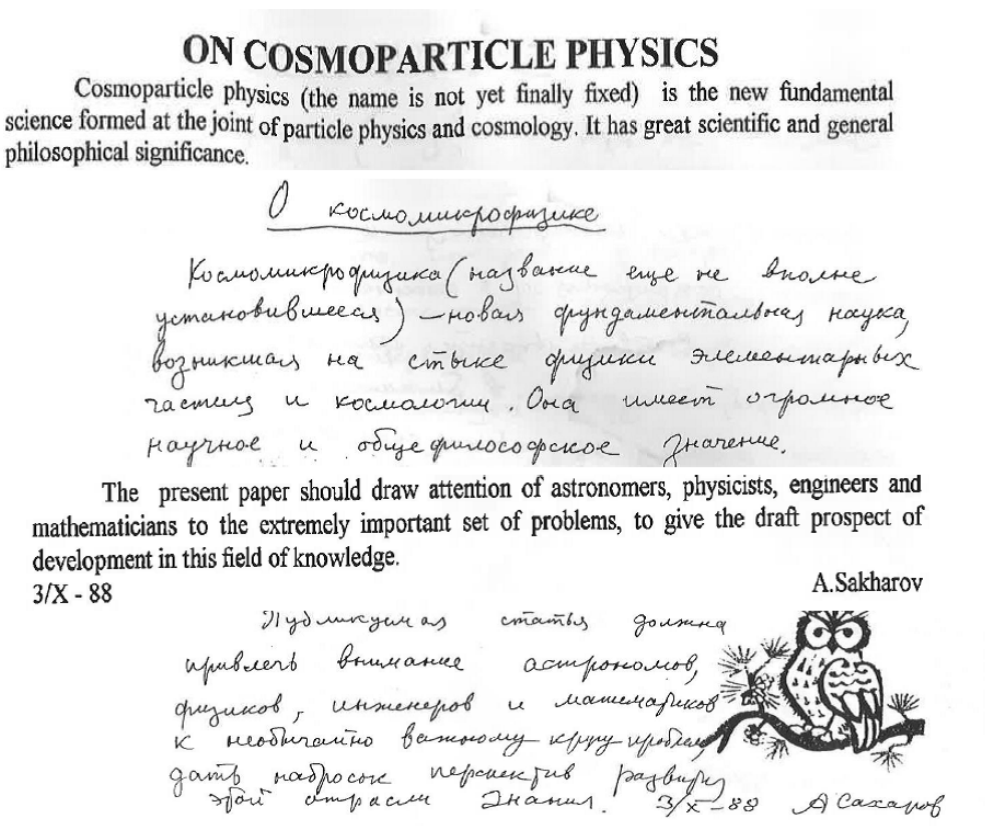
Figure 1. The direct reproduction of the beginning and end of the handwritten original of Sakharov’s article [1] and of its English translation taken with the corresponding permission from the Preface to the Proceedings 1 International conference on Cosmoparticle physics “Cosmion-94”